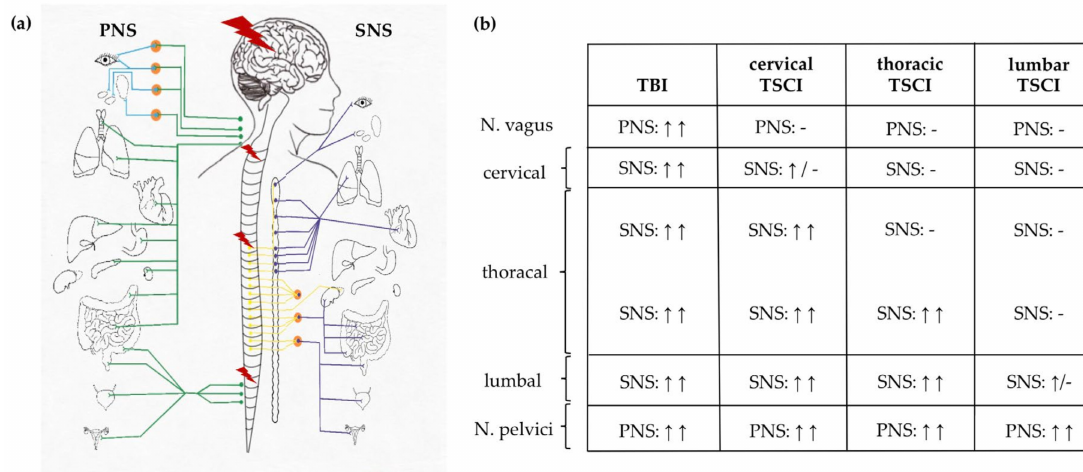
Figure 3. Differential effects of TSCI and TBI on the autonomic nervous system (ANS) depending on the trauma level. ( a ) The parasympathetic innervation of thoracic and upper abdominal organs originates from the cranial nerve N. vagus, while the innervation of the lower abdominal and pelvic organs (Cannon’s point) originates from the spinal cord segments S2-S4 (Nn. splanchnici pelvicii). The sympathetic innervation via the sympathetic trunk originates from the spinal cord segments T1-L3. ( b ) While TBI results in general dysregulation ( ↑↑ ) of PNS and SNS, TSCI commonly spares the N. vagus (except for high cervical trauma), while its effects on the SNS are dependent on the localisation of trauma. Graphics adapted from [4,85]. Abbreviations: N. = Nervous, PNS = parasympathetic nervous system, SNS = sympathetic nervous system, TBI = traumatic brain injury, TSCI = traumatic spinal cord